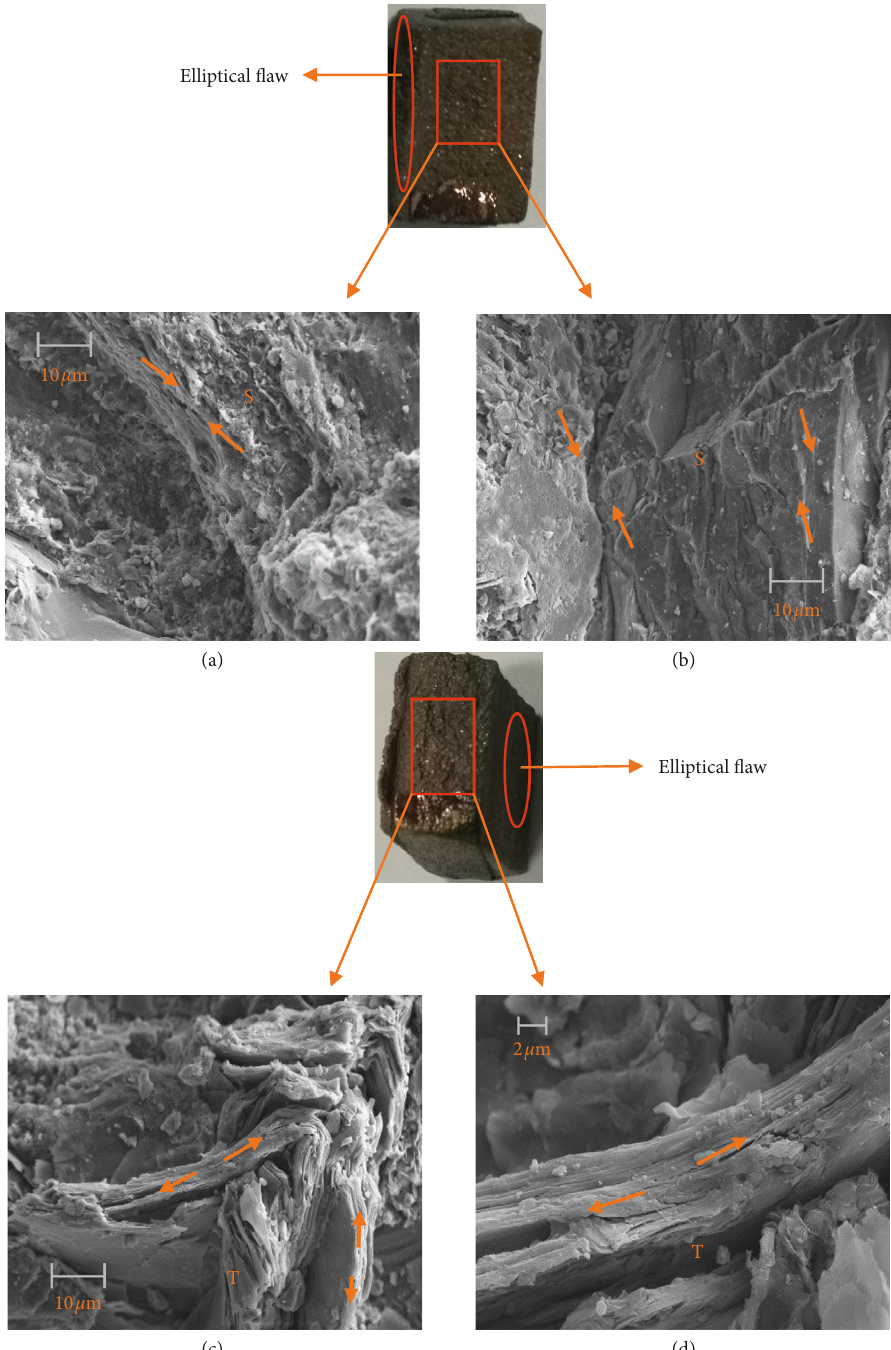
Figure 15: SEM images of typical crack coalescence between two flaws: (a, b) specimen S-45-0; (c, d) specimen S-90-0. The opposite arrows and the reverse arrows represent slipping and tensile area, respectively, and S and T represent shear and tensile cracks,